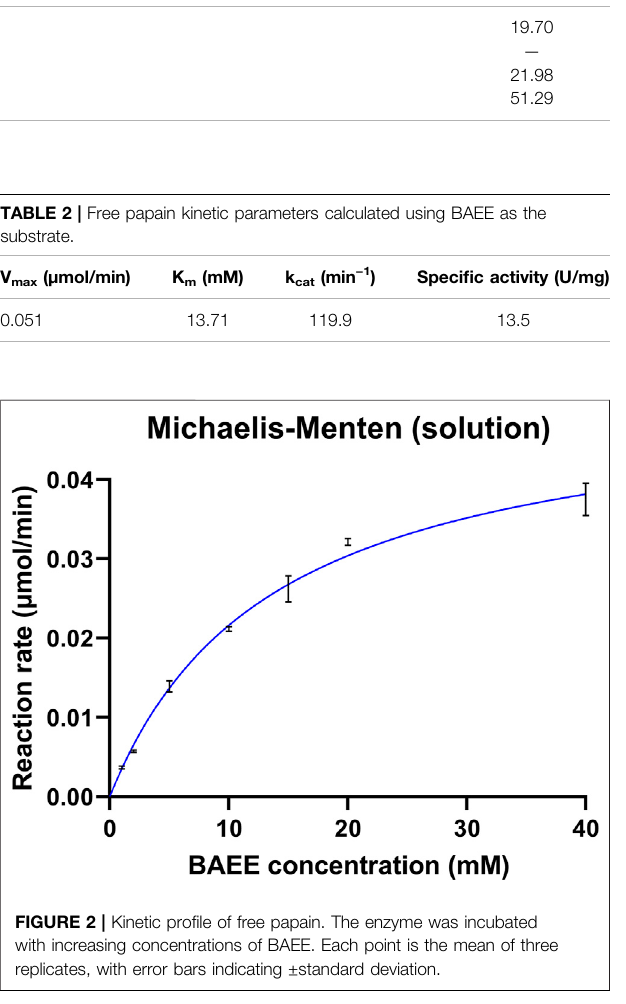
TABLE 1 | Results of the 24 h incubation of 100 µl of 0.5 mg/ml RTX with 1 µg of free papain in different conditions. Digestion yields are calculated as the ratio between the digested mAb area after incubation and the intact mAb area before incubation obtained from the HPLC-UV analysis of the reaction mixtures. Reaction conditions